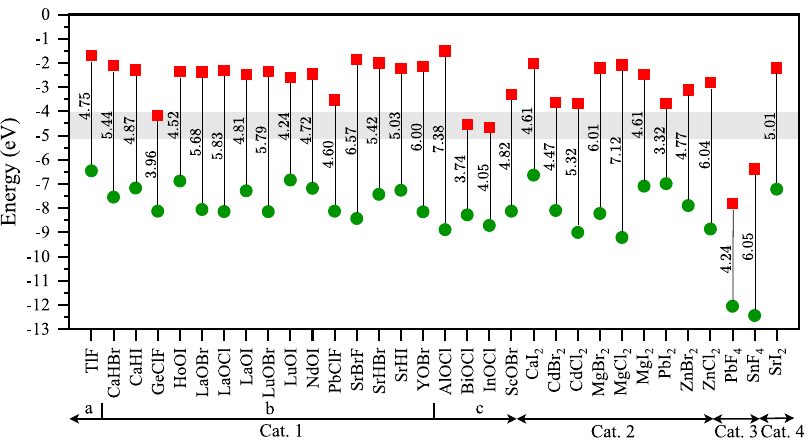
Fig. 3 Conduction (red square) and valence (green circle) band edge of 32-monolayer material with respect to the vacuum level (0 eV). The lines indicate the obtained band gap with corresponding value in eV. Values are calculated using a hybrid HSE06 functional. A channel material with a 4 eV af fi nity and a 1 eV band gap is added as a gray band